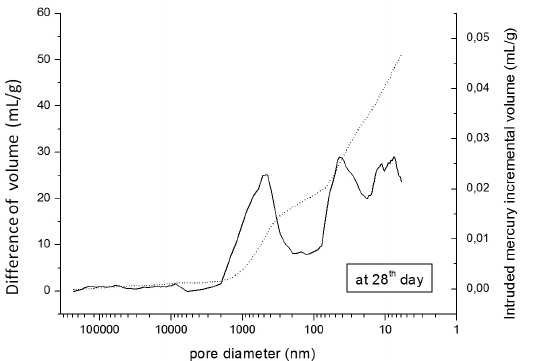
Figure 16. Porosimetry of fiber cement D at six months of